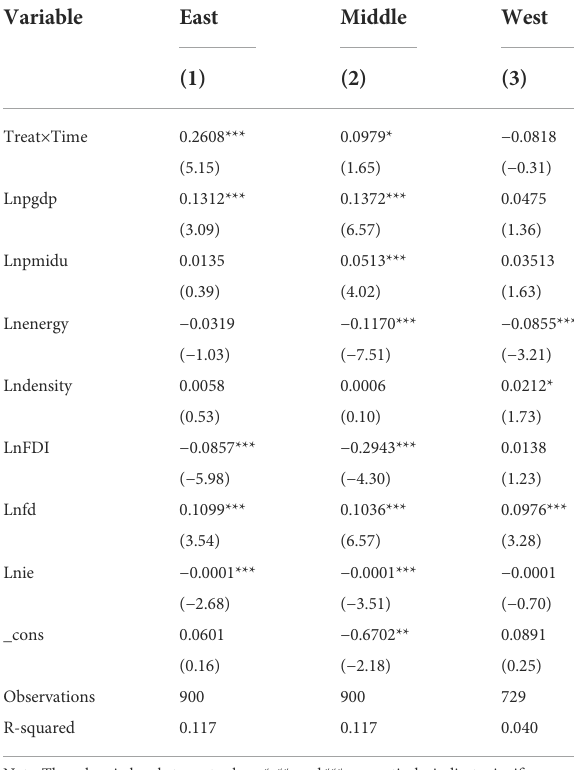
TABLE 9 Regional heterogeneity regression results